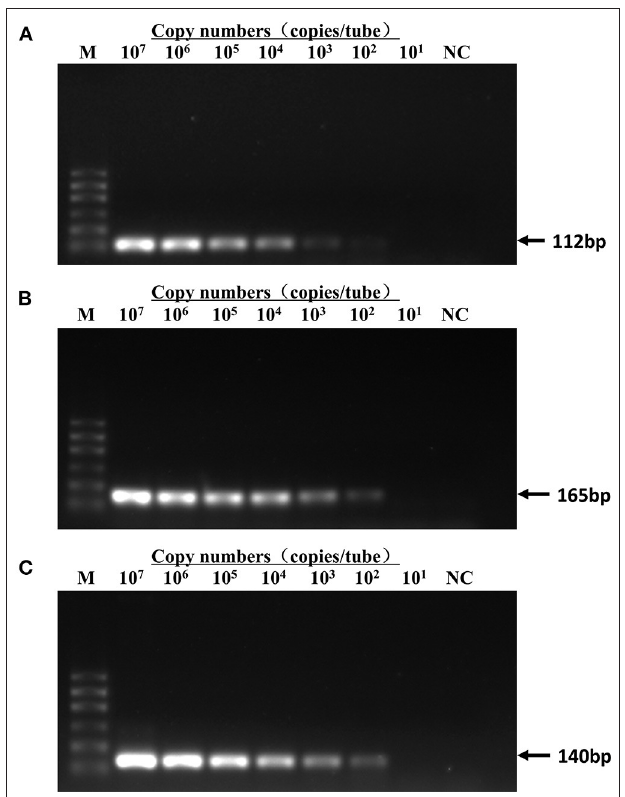
FIGURE 3 | Detection limit of conventional PCR. Templates of pMD18T-FPV (A) , pMD18T-FCV-1 (B) , and pMD18T-FHV-1 (C) were diluted by 10 times gradient to a dilution factor that could not be detected by conventional PCR. The detection limit was 5 × 10 3 copies/assay for FPV and 5 × 10 2 copies/assay for FCV and FHV-1. Template amount for curves 2–8 lanes was 5 × 10 7 -5 × 10 1 copies/assay. M, DL600 marker; NC, negative control.